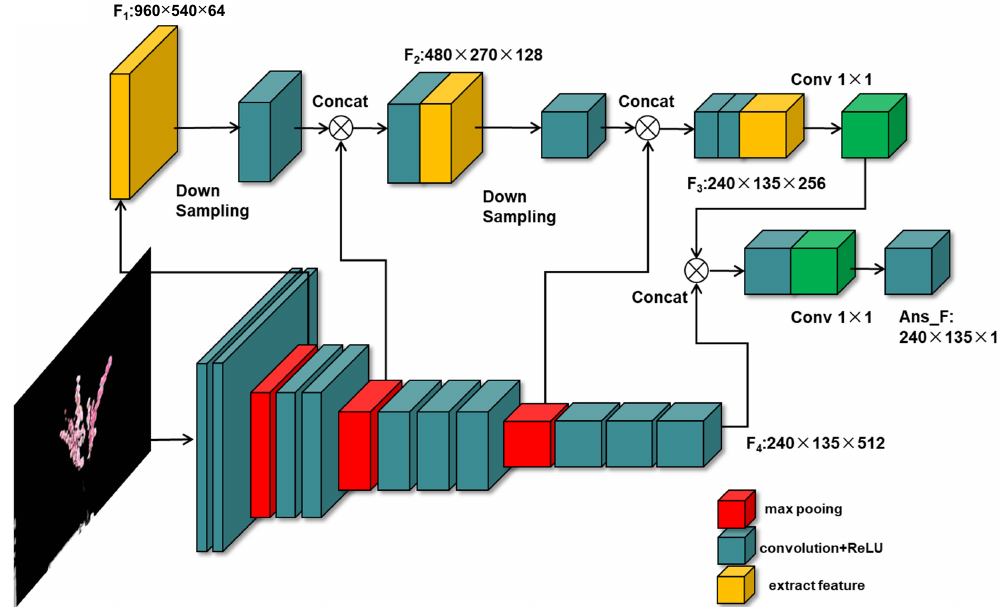
Figure 4. Architecture of multi-scale feature fusion